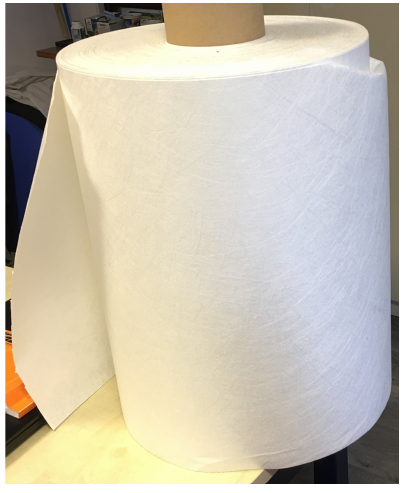
Figure 2. Non ‐ woven plastic tissue (Evolon ® microfilaments). Figure 2. Non-woven plastic tissue (Evolon ®